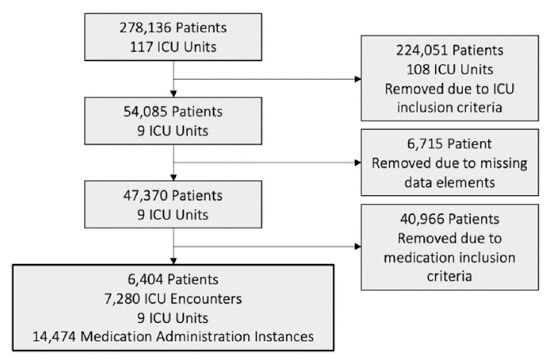
Figure 1. Flow chart detailing dataset inclusion criteria.